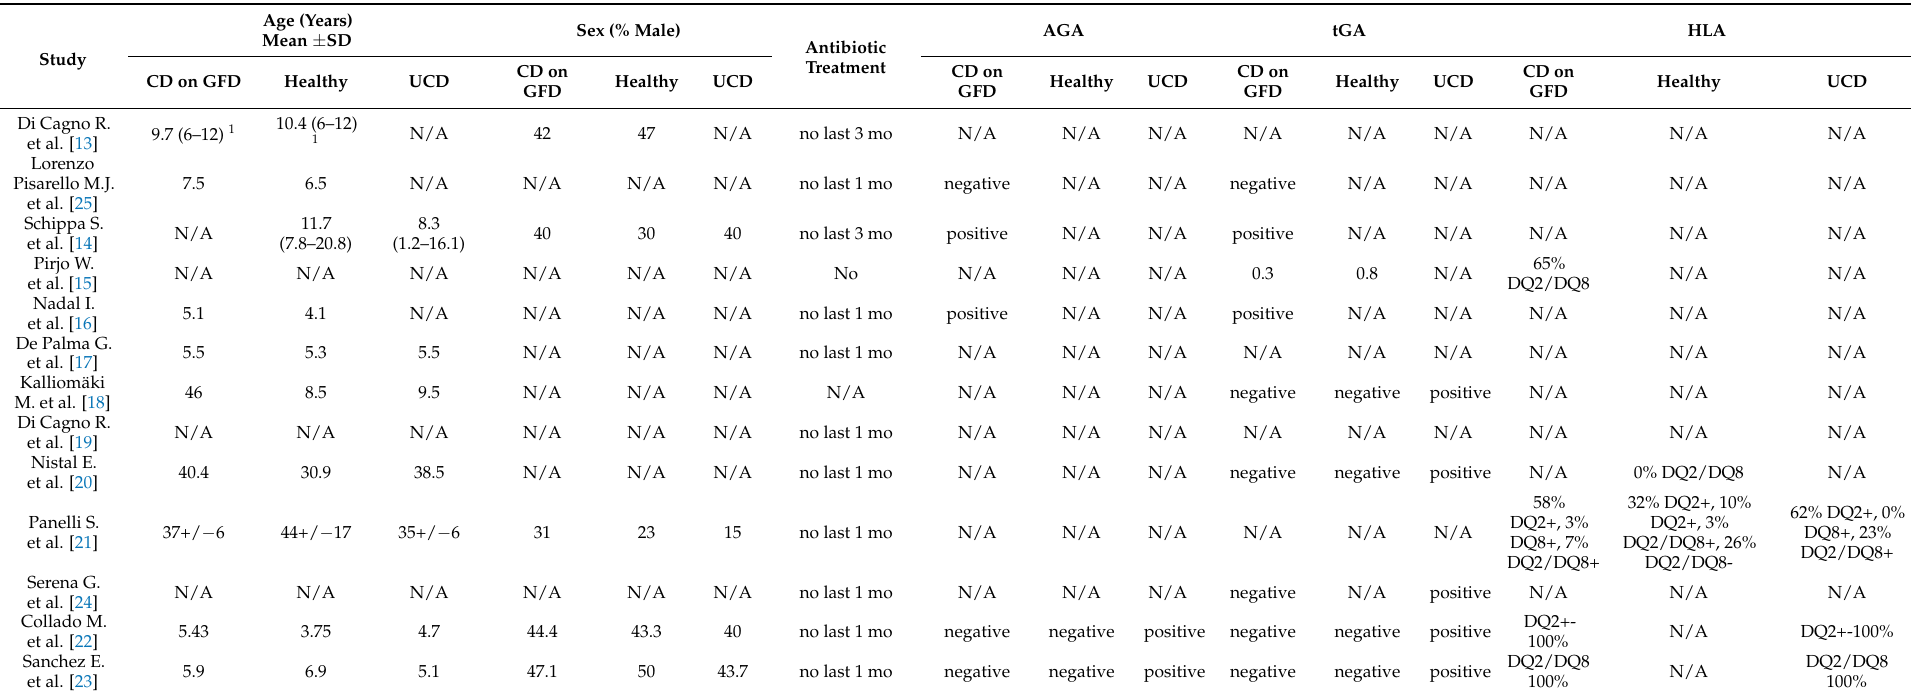
Table 2. Characteristics of the study population ( n =